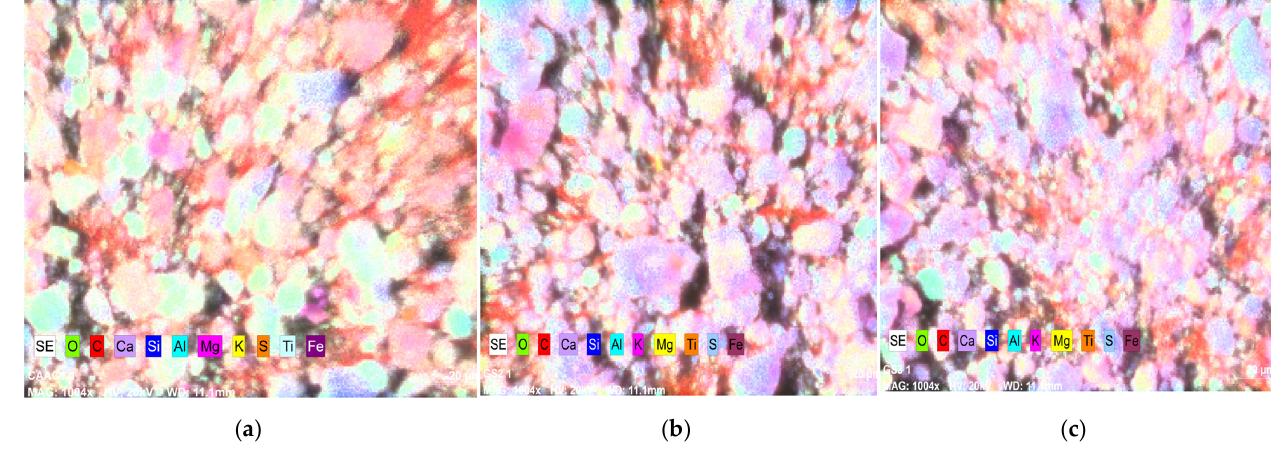
Figure 20. EDAX images of AAC specimens: ( a ) CAAC-C, ( b ) CAAC-F, ( c ) GGBS-CE-AAC-F.